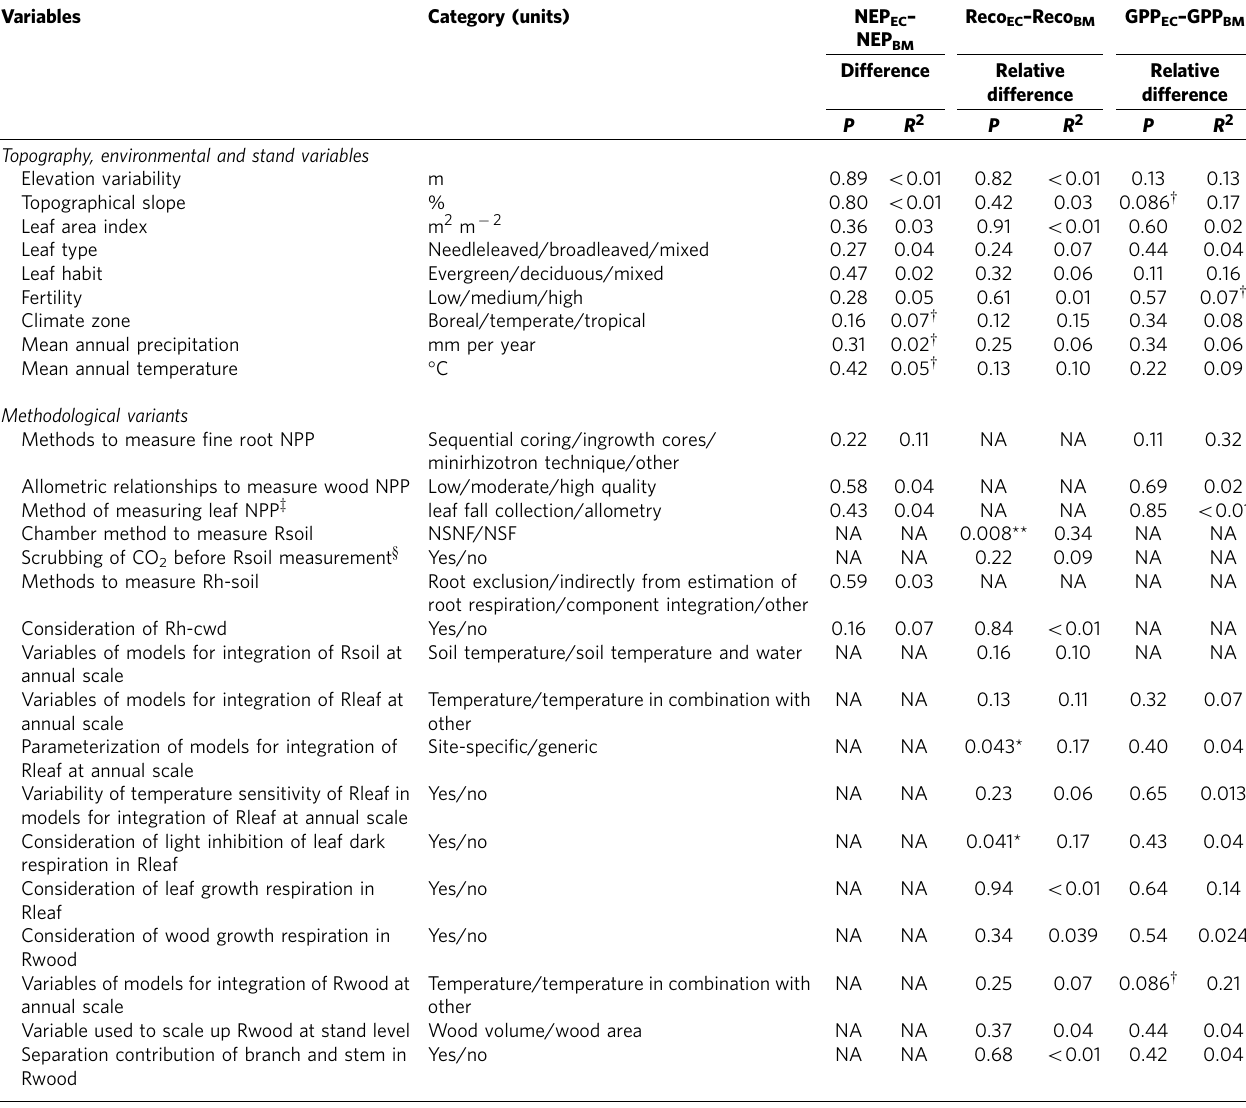
Table 3 | Relationship between the difference in forest carbon fluxes estimated from eddy-covariance and biometric methods and site or methodological